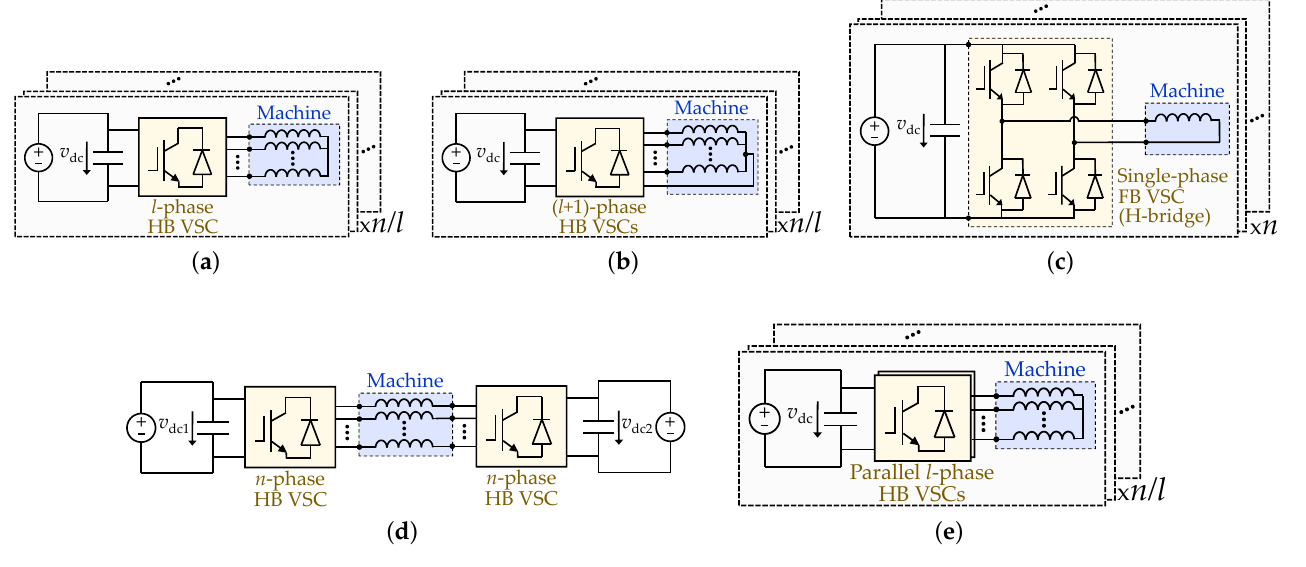
Figure 9. VSC modular topologies in multiphase ac drives, ignoring postfault reconfiguration. ( a ) Multiple independent l -phase HB VSCs. ( b ) Multiple independent ( l +1)-phase HB VSCs. ( c ) Multi- ple independent single-phase FB VSCs (H-bridges). ( d ) Dual n -phase HB VSC for open-end windings. ( e ) Multiple independent parallel l -phase HB